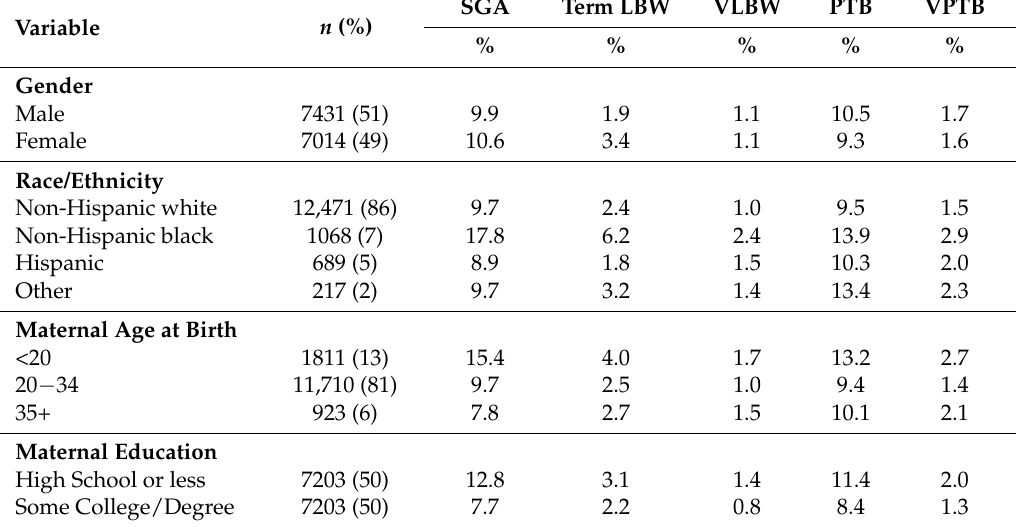
Table 2. Distribution of demographic and economic covariates across the population of live singleton births ( n = 14,445) and the prevalence of outcomes by covariates in Atrazine Monitoring Program communities in Ohio,